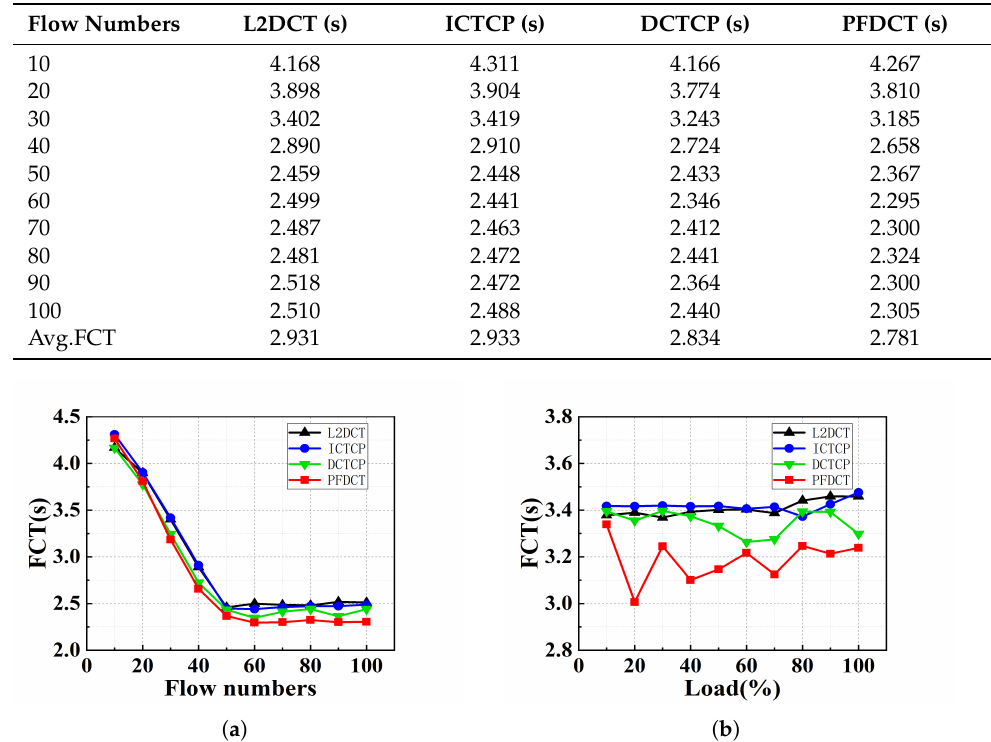
Table 2. The average FCT with varying numbers of senders sending 15 KB flows in simple-scale topology.